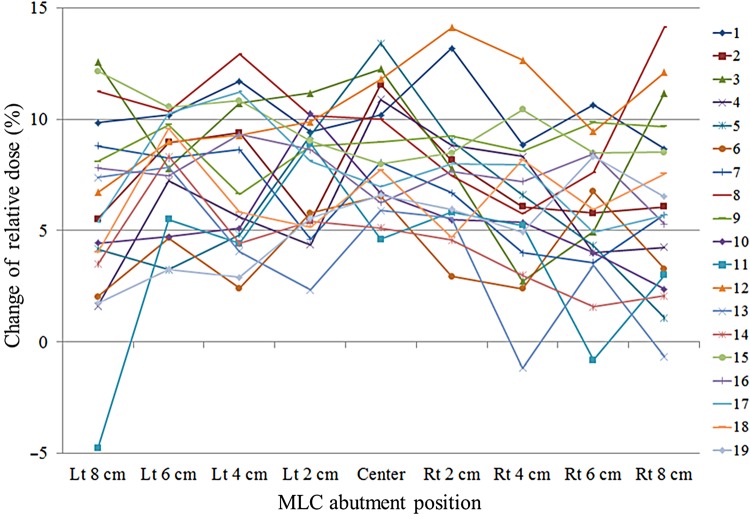
Example of the changes in relative dose at a gantry angle of 180° as compared with those at a gantry angle of 0° for 19 leaves. The x-axis shows the MLC abutment positions ranging from 8 cm to the left to 8 cm to the right at 2-cm intervals, and the y-axis shows the changes in relative dose. Individual leaf numbers are represented by different colored lines.